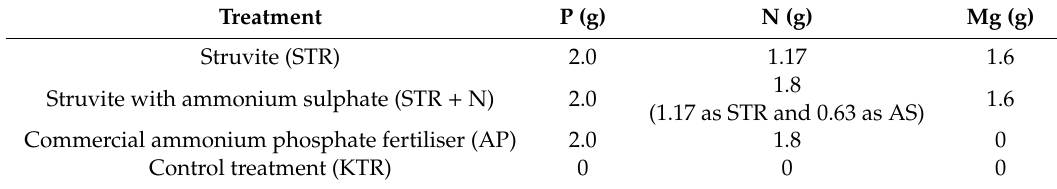
Table 1. Doses of compared nutrients in the pot